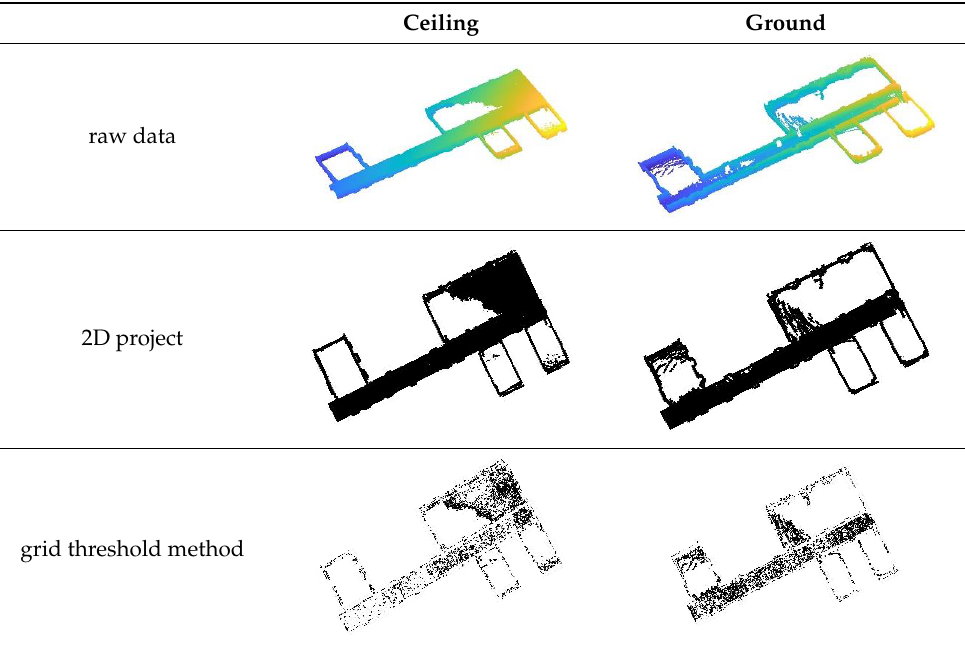
Finally, we set 1 threshold and 2 threshold of the distance from the point to the S and the floor S is the data S planes to determine the ceiling S , and the wall c w r g S and except for S . The entire process is shown in Table 1. c g Table 1. The process of extracting the wall: Project the initial data onto a plane, and then the ground Table 1. The process of extracting the wall: Project the initial data onto a plane, and then the ground Table 1. The process of extracting the wall: Project the initial data onto a plane, and then the ground Table 1. The process of extracting the wall: Project the initial data onto a plane, and then the ground Table 1. The process of extracting the wall: Project the initial data onto a plane, and then the ground data are screened by the grid threshold method. The ground is restored to a three-dimensional form data are screened by the grid threshold method. The ground is restored to a three-dimensional form data are screened by the grid threshold method. The ground is restored to a three-dimensional form data are screened by the grid threshold method. The ground is restored to a three-dimensional form data are screened by the grid threshold method. The ground is restored to a three-dimensional form and treated with the SOR filter. The ground and ceiling are fitted into a plane; then, the wall data are and treated with the SOR filter. The ground and ceiling are fitted into a plane; then, the wall data and treated with the SOR filter. The ground and ceiling are fitted into a plane; then, the wall data and treated with the SOR filter. The ground and ceiling are fitted into a plane; then, the wall data and treated with the SOR filter. The ground and ceiling are fitted into a plane; then, the wall data extracted by setting thresholds. are extracted by setting are extracted by setting thresholds. are extracted by setting thresholds. are extracted by setting thresholds.